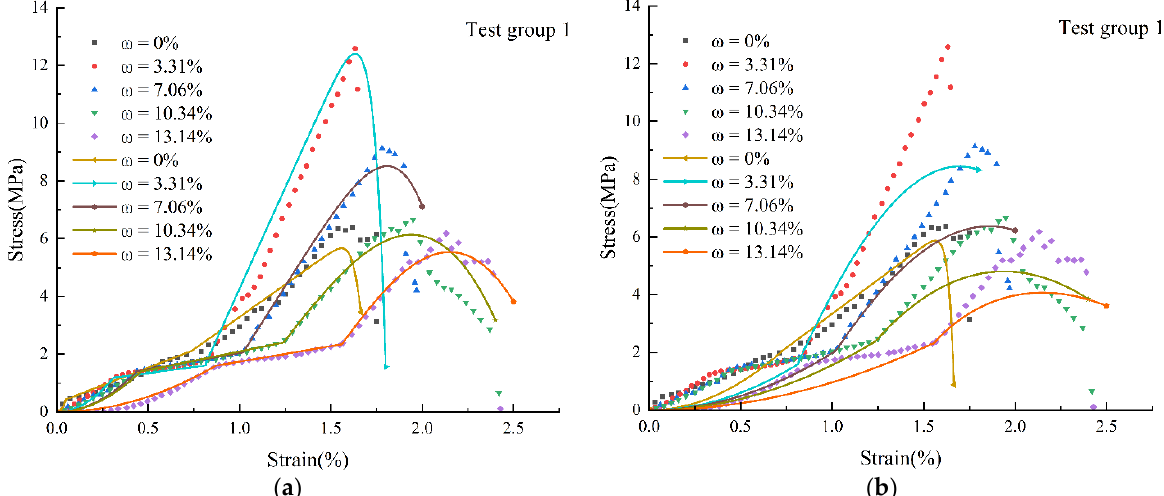
Figure 9. The uniaxial compression test data points and theoretical model curve of coal samples in test group 1: ( a ) the author’s model; ( b ) the comparison model.